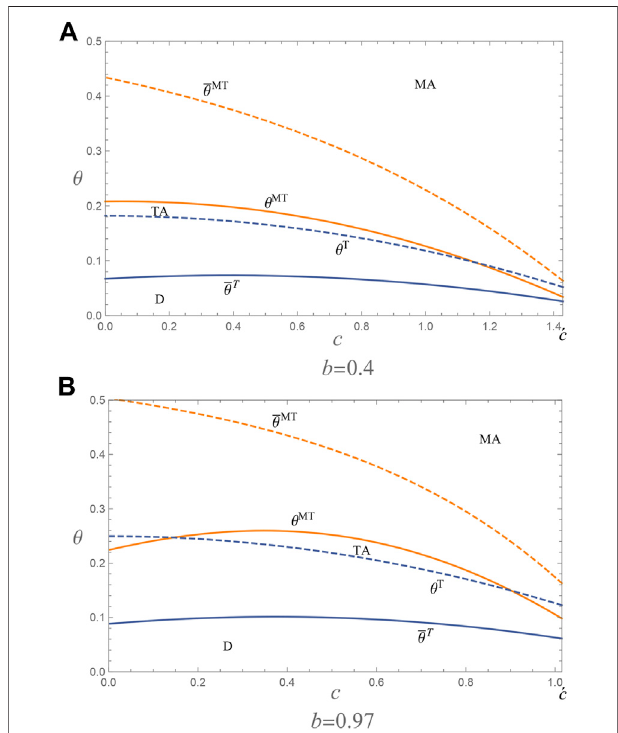
FIGURE 5 | Optimal channel strategy in dominant manufacturer and dominant retailer in different case: (A) a = 1, b = 0.4; (B) a = 1, b = 0.97.